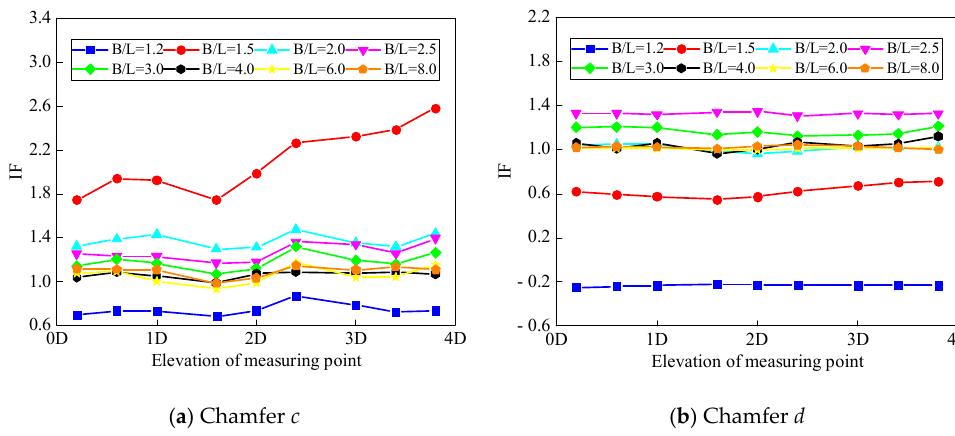
Figure 13. IF on chamfered corners at different elevations